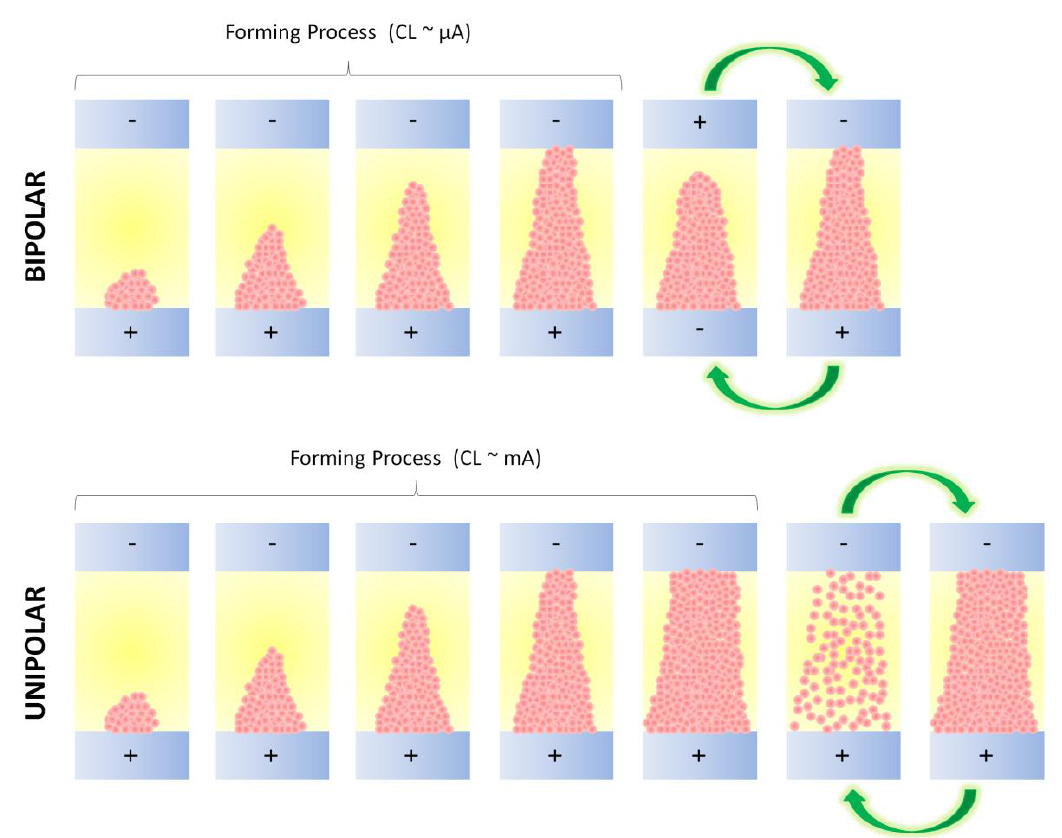
Figure 1. Comparative schematic between bipolar and unipolar resistive switching mechanisms (reoxidation for bipolar and thermal heat for unipolar). The blue and yellow stacks represent the metallic electrodes and insulator (respectively), and the pink circles represent the particles that form the conducting